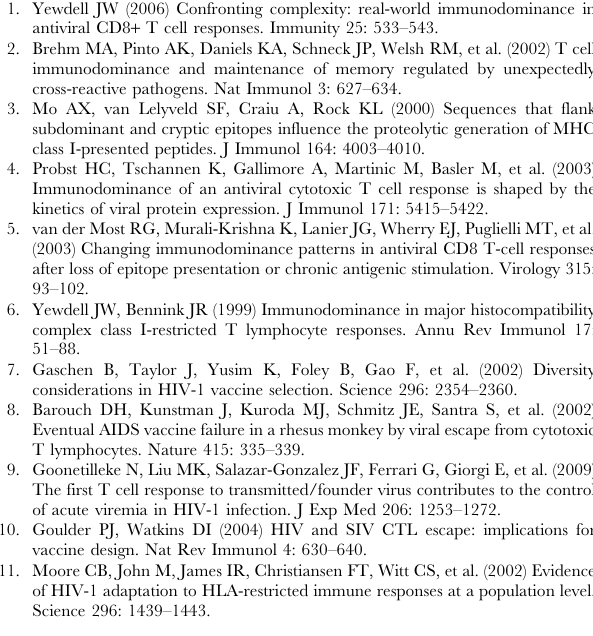
Figure S1 Stability and expression of modified immunogens.